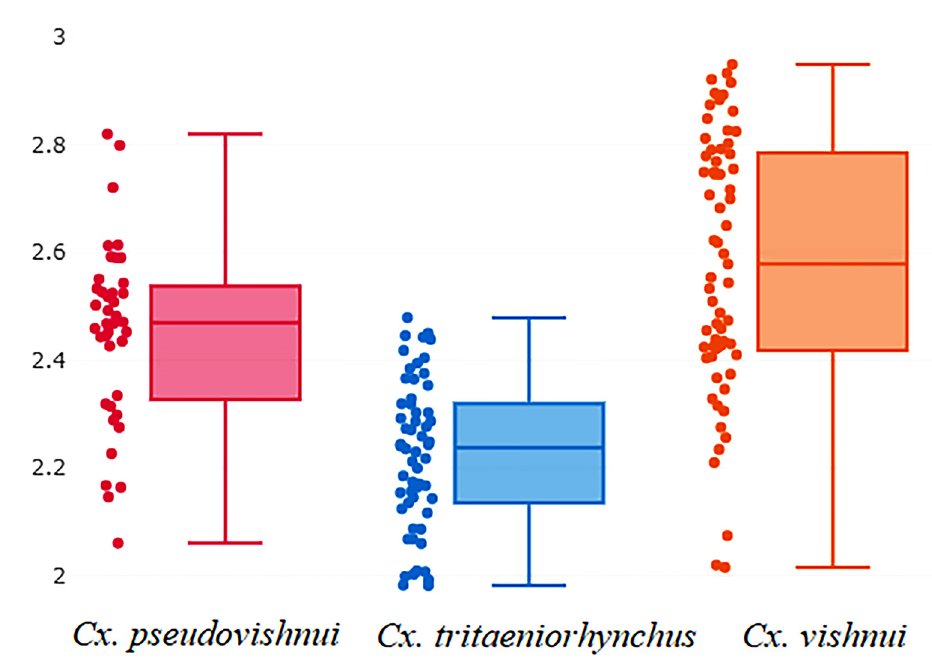
Figure 4. Boxplot of the wing centroid size of Cx. pseudovishnui , Cx. tritaeniorhynchus , and Cx. vishnui . Each box represents the wing size data of each Culex species, and the group median that separates the 25th and 75th quartiles is displayed in each box. Table 1. Statistical differences in mean wing centroid size of Cx. pseudovishnui , Cx. tritaeniorhynchus , and Cx. vishnu i .